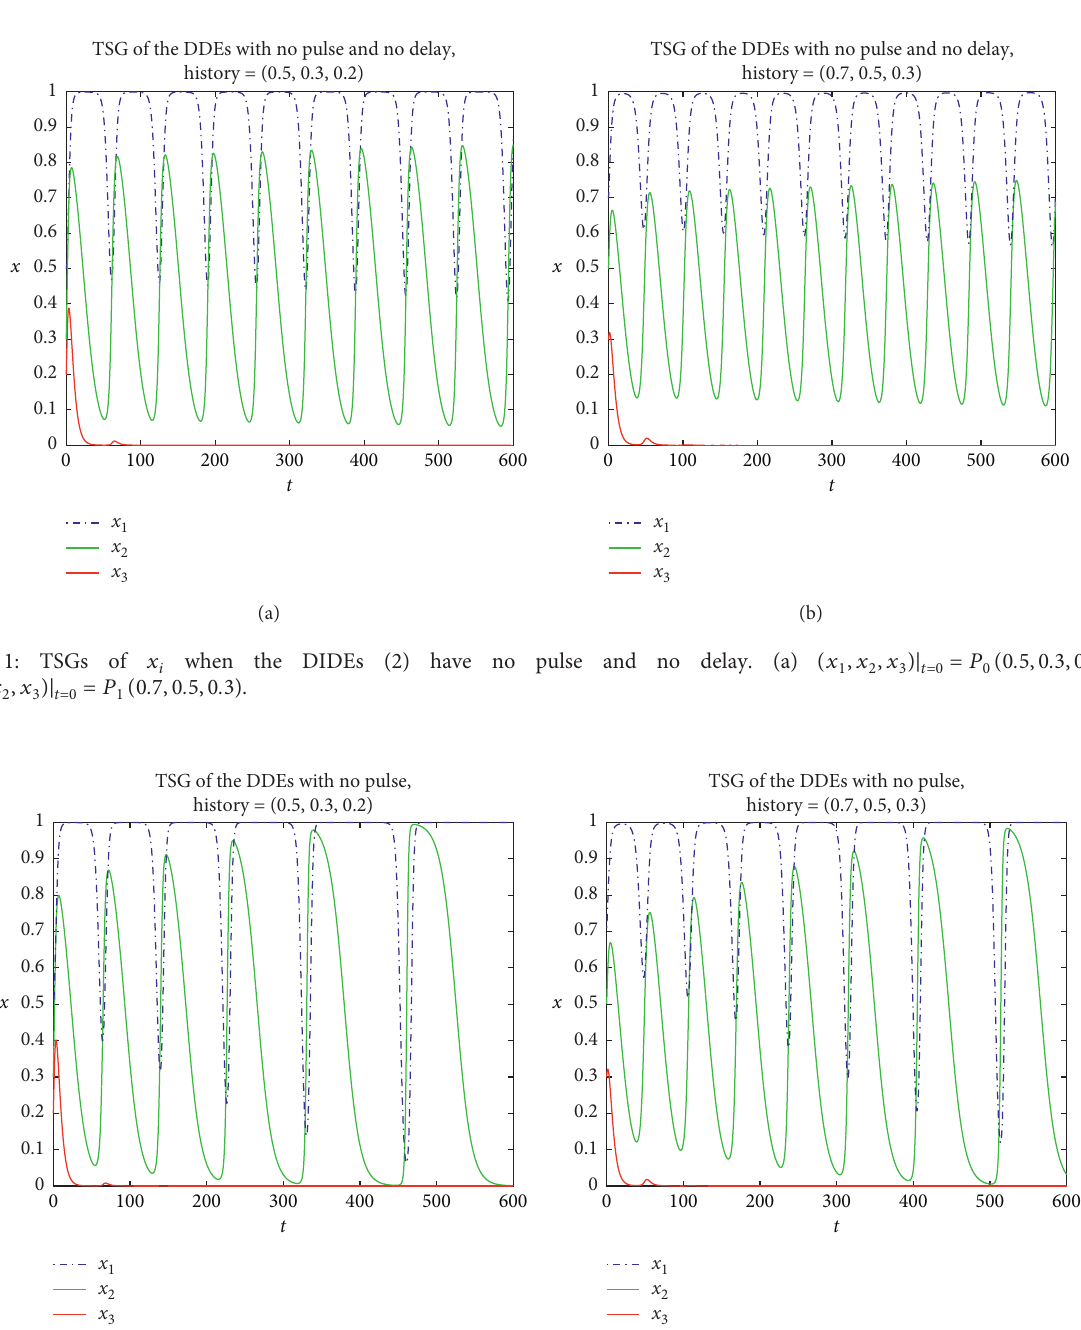
, x ,x )| � P ( 0 . 5 , 0 . 3 , 0 . 2 ) and (b) t � 0 1 2 3 0